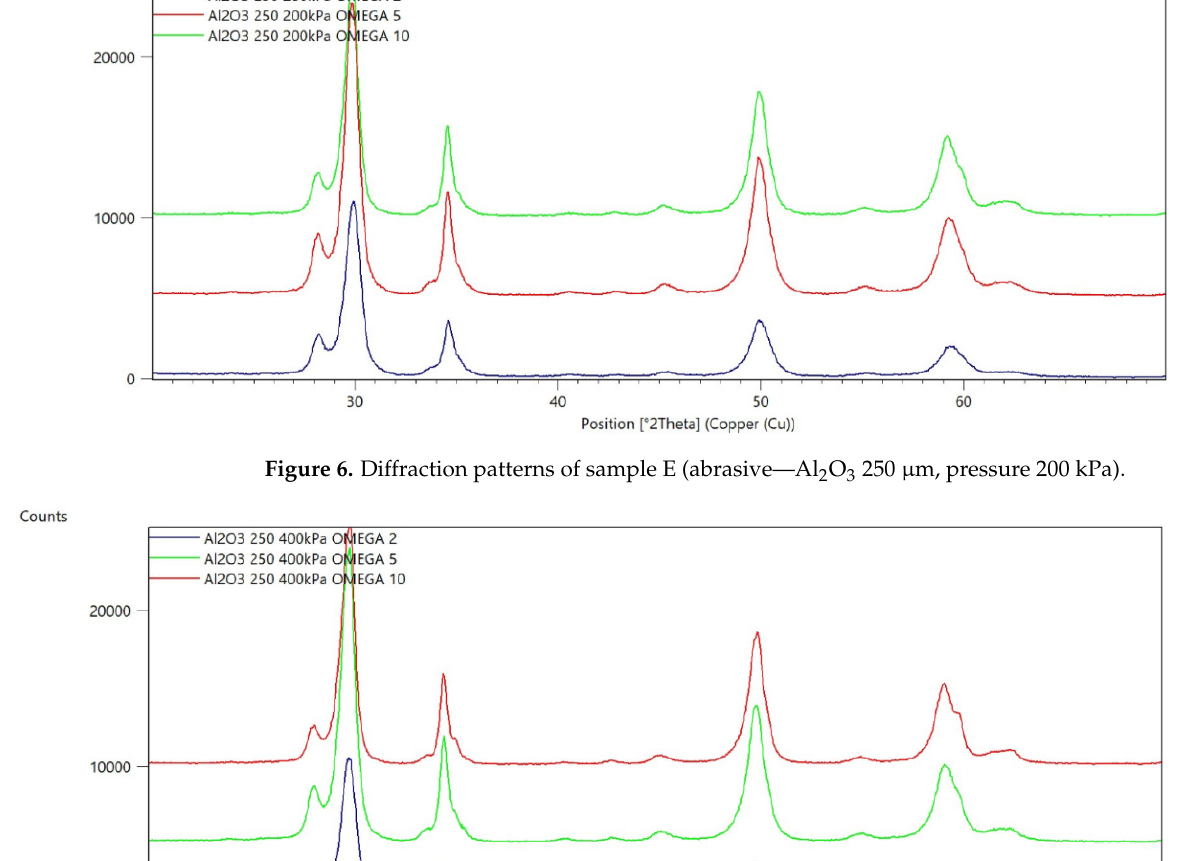
Figure 5. Diffraction patterns of sample D (abrasive—Al 2 O 3 110 μ m, pressure 400 kPa).